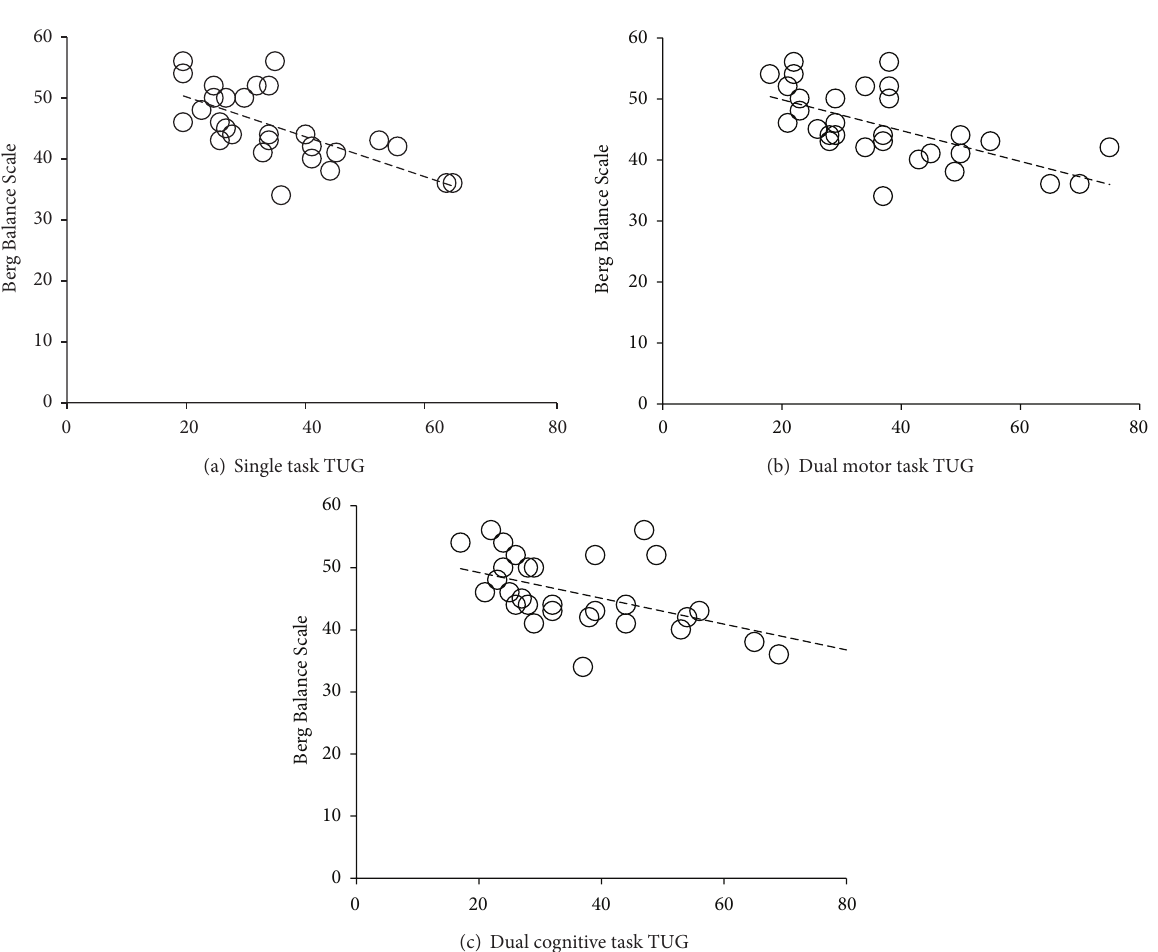
( 𝑟 𝑠 = −0.65 ; 𝑃 = 0.001 ), dual-cognitive task condition ( 𝑟 𝑠 = −0.61 ; 𝑃 = 0.001 ), and BBS. The scatter plots for each task condition are presented in Figures 3 and